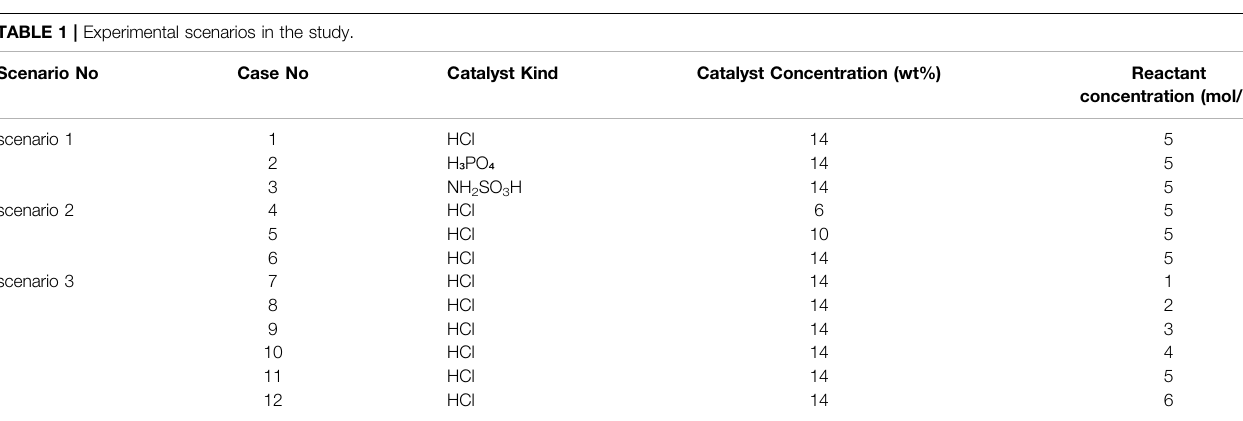
Table 1 ). Temperature, gas production rate, and (the total of